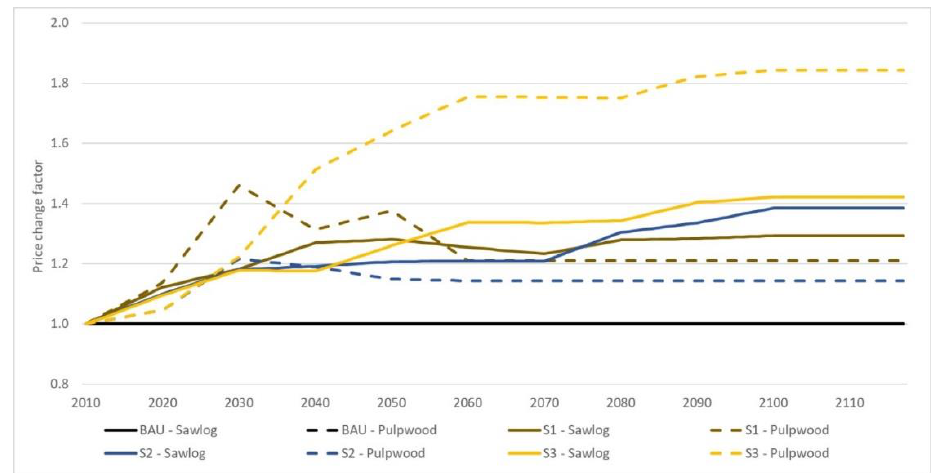
Figure 3. Annual dynamic price change factors used for Business as usual (BAU), S1, S2, and S3, using 2010 as start year. The BAU scenario had no dynamic price change and was included in the graph for reference.